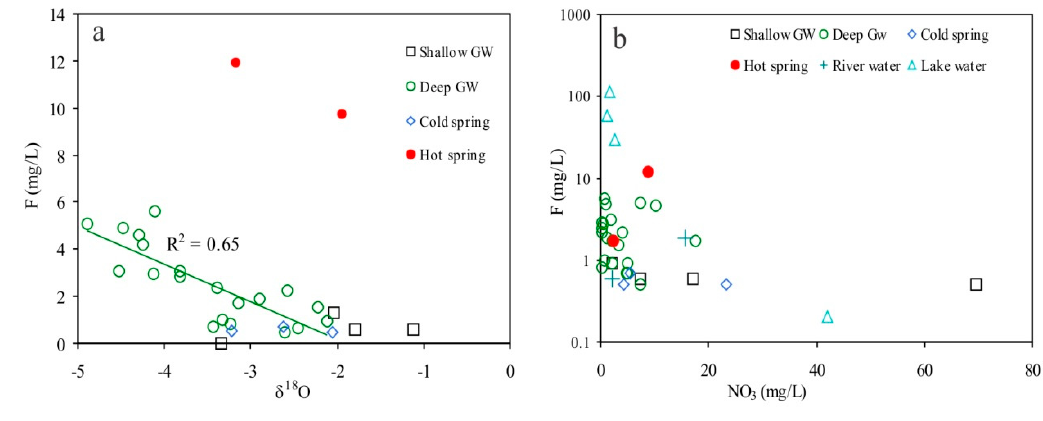
Figure 9. ( a ) Plot of δ 18 O vs. F − and ( b ) NO 3 − vs. F − .